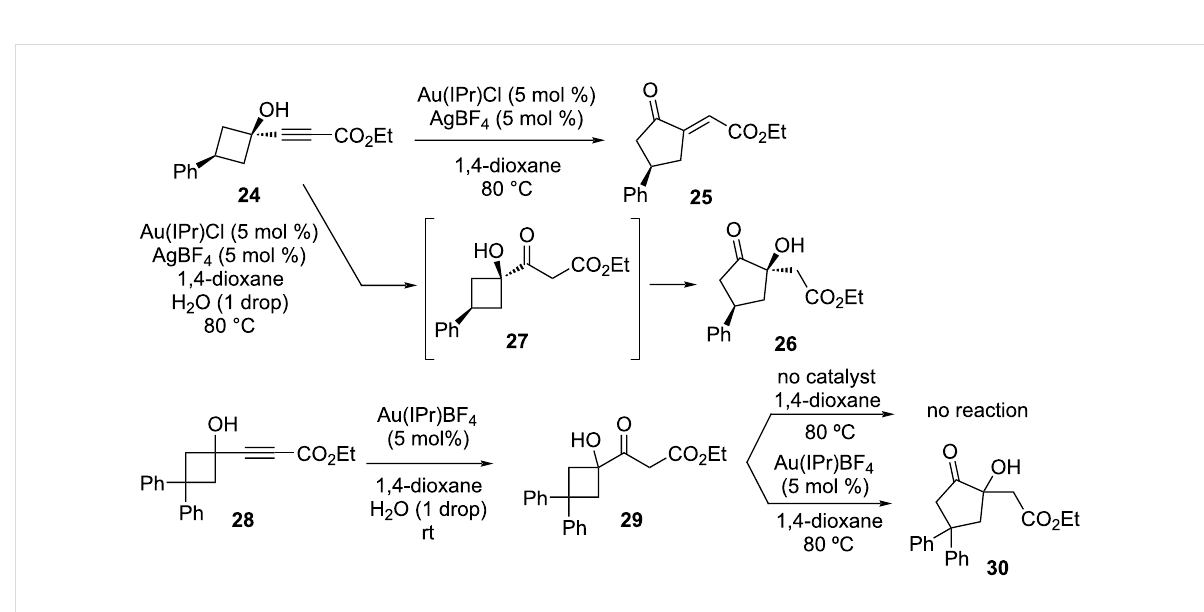
Figure 7: In the presence of a gold catalyst and water in 1,4-dioxane, 1-alkynylbutanol derivatives undergo tandem hydration and α -ketol rearrange- ment to give the corresponding ring-expanded cyclopentanones. IPr = N , N ′